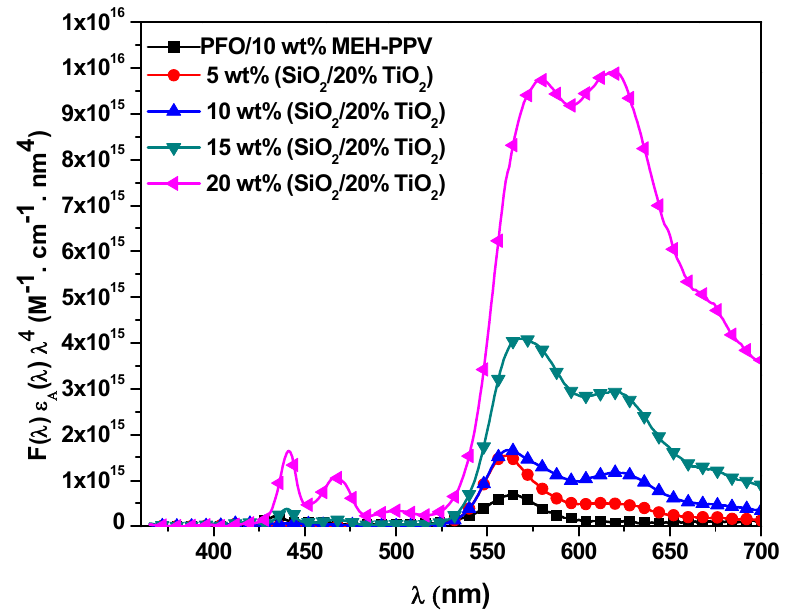
Figure 6. F ( λ ) ε ( λ ) λ 4 versus wavelength for PFO/MEH-PPV with various ratios of STNCs. Figure 6. F( λ ) ε ( λ ) λ 4 versus wavelength for PFO/MEH ‐ PPV with various ratios of STNCs. Table 2. Energy Transfer Parameters of PFO/10 wt% MEH-PPV hybrid thin film with various content of